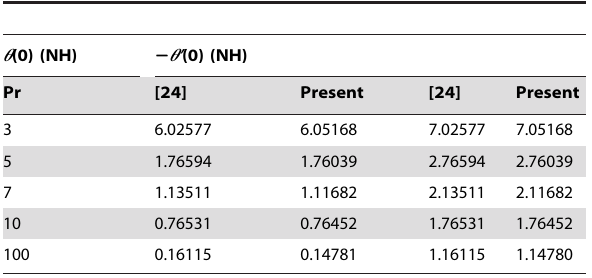
Table 4. Values of Skin-friction coefficient Re x ð Þ 1 = 2 C f for different values of K and n